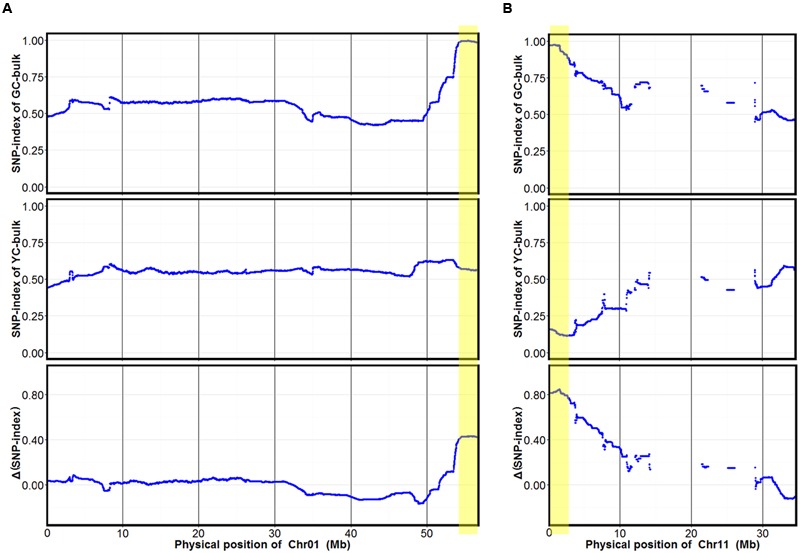
SNP-index of GC and YC bulks and Δ(SNP-index) plots generated by sliding-window analysis on soybean chromosomes 1 (A) and 11 (B). The X-axis shows physical positions of chromosomes and the Y-axis the average SNP-index in each 2-Mb physical interval with a 10-kb sliding window. Two candidate genomic regions (marked in yellow) were defined using the criteria of average SNP-index > 0.9 in the GC bulk and average P-value < 0.05.